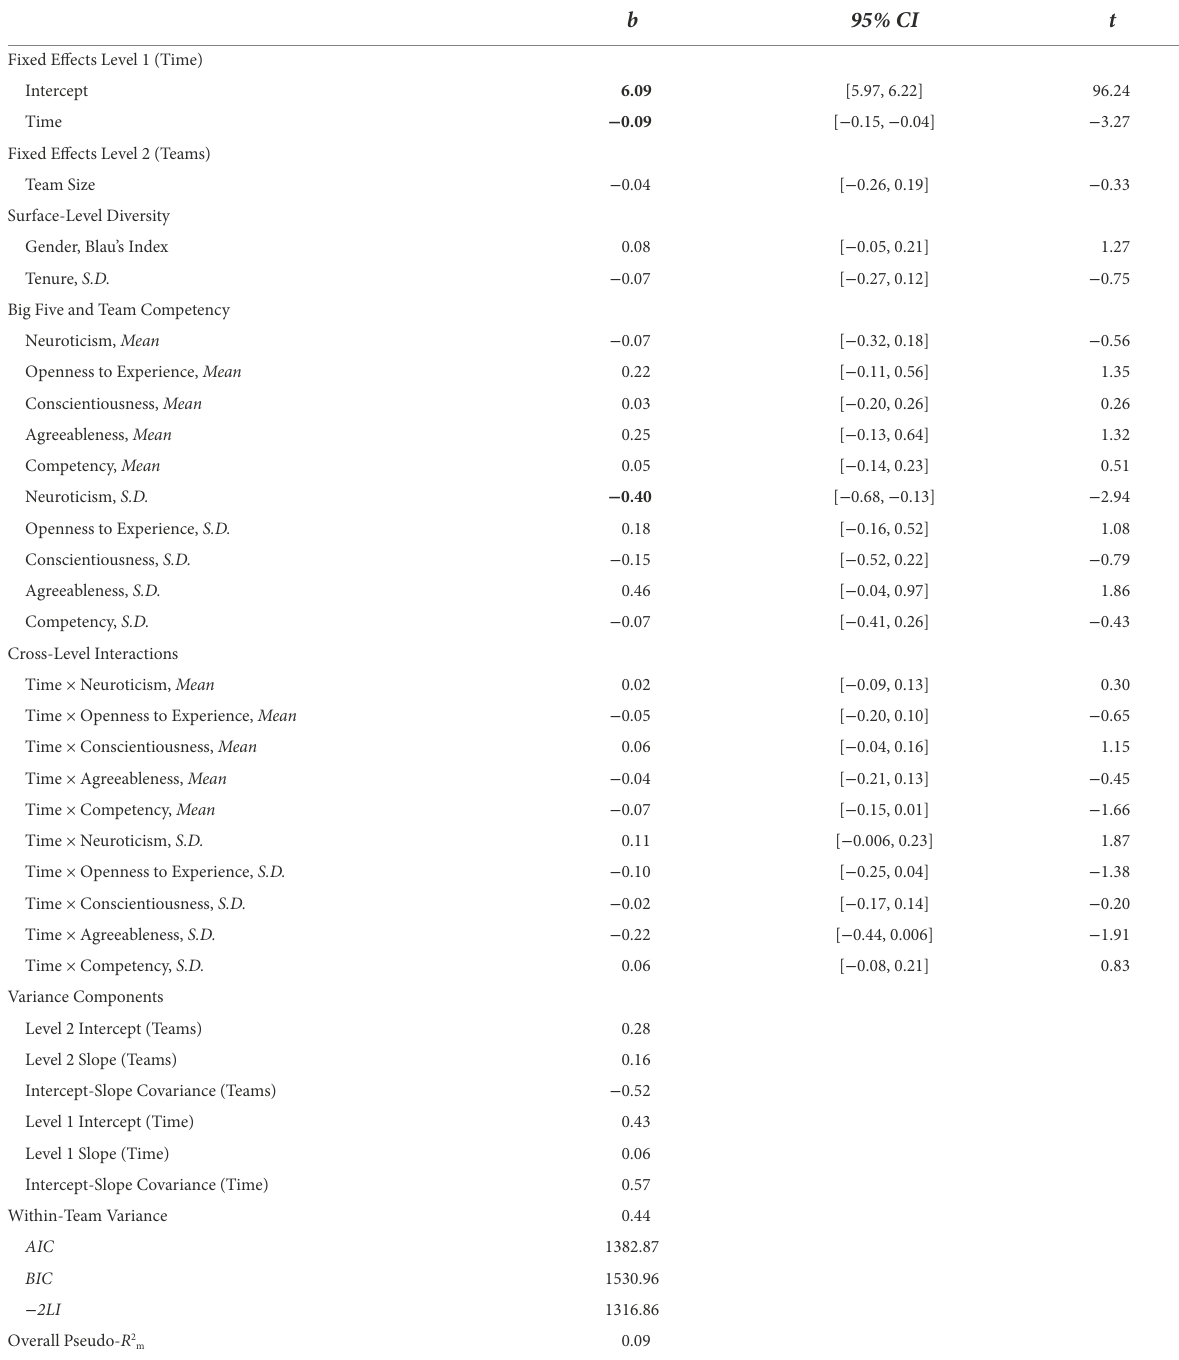
Table 6 Linear Growth Curve Model ( n = 699 measurements nested in three time points, in 233 members in 61 teams) for changes in team psychological safety predicted by team personality and competency (Model 12). Parameter